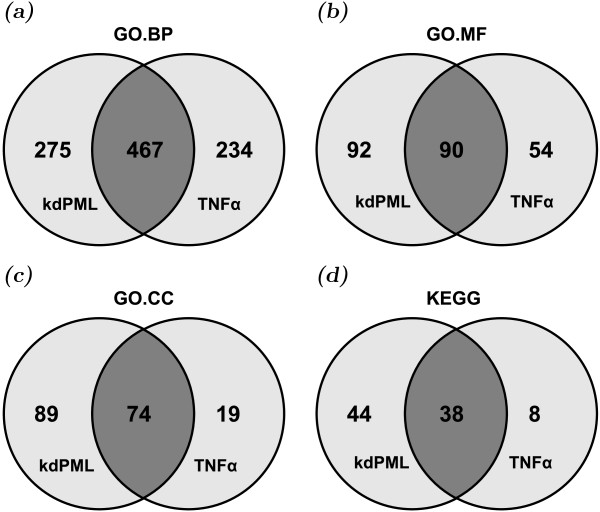
Functional ontology analyses of PML knockdown responsive genes and TNFα treatment affected genes. The identified gene lists were analyzed by the Hyper-Geometric test (q < 0.01) as described in Methods to identify the over-represented terms of (a) GO.BP, (b) GO.MF, (c) GO.CC and (d) KEGG pathways affected by PML knockdown (“kdPML”) and TNFα treatment (“TNFα”). Two parental GO terms were removed to reduce redundancy of the GO term definition. GO.BP, Gene Ontology Biological Process; GO.MF, Gene Ontology Molecular Function; GO.CC, Gene Ontology Cellular Component; KEGG, Kyoto Encyclopedia of Genes and Genomes.